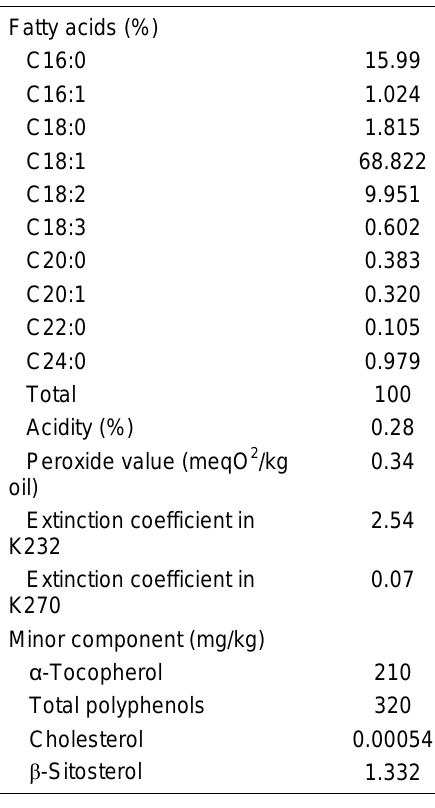
Main Composition of the VOO Administered to Rat